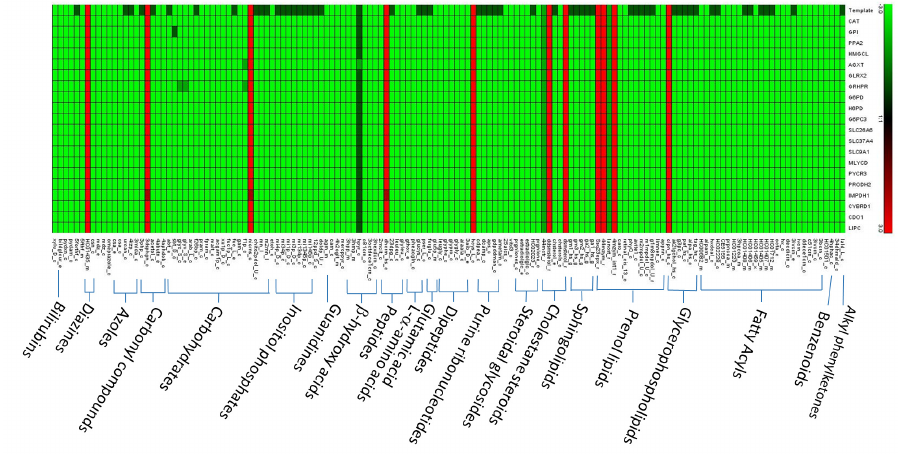
Figure 7. Flux variance patterns for the template and 20 mutants. Green indicates complete decrease, dark green means partial or inclusive decrease, and red denotes complete